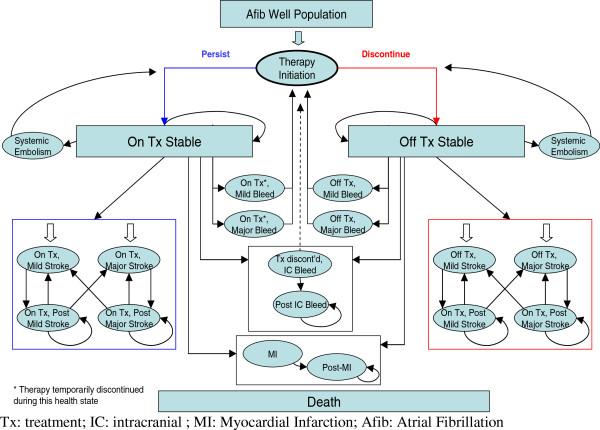
Model structure.